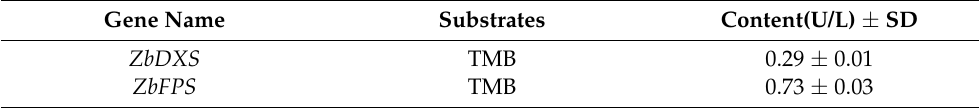
Figure 3. Analysis of expressed fusion proteins containing ZbDXS ( a ) and ZbFPS ( b ). Lane 1: unin- duced; Lane 2: total proteins from IPTG-induced; Lane M: protein marker; Lane 3: proteins from the sediment; Lane 4: proteins from the supernatant; Lane 5: proteins from the flow-through; Lane 6: proteins from the first elution; Lane 7: proteins from the second elution; Lane 8: Concentrated pro- tein. Table 1. Analysis of ZbDXS and ZbFPS in vitro ELISA. Table 1. Analysis of ZbDXS and ZbFPS in vitro ELISA.